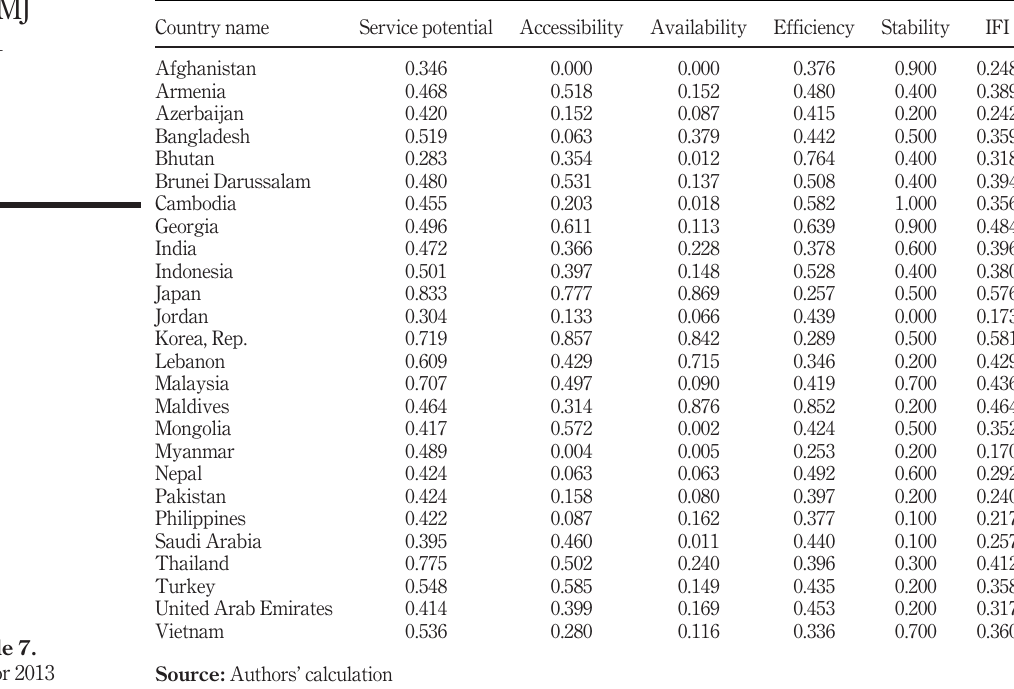
Table 7. IFI for